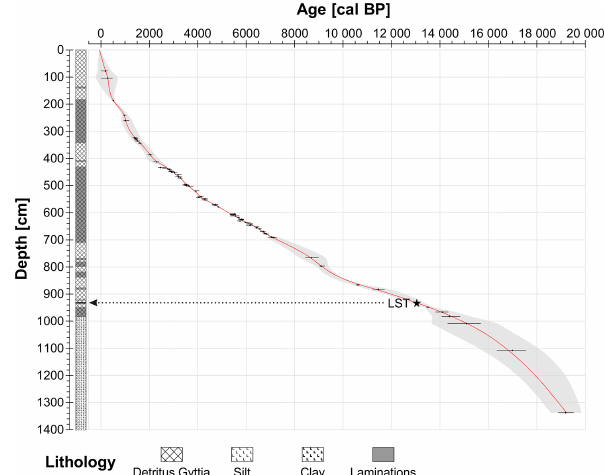
Figure 2. Age–depth model and lithology of Moossee. Black dots show the calibrated ages with 95% (2 σ ) probabilities (IntCal13; Reimer et al., 2013). The red line is the modeled chronology using OxCal 4.3 from 435 to 691cm (V-sequence; Bronk Ramsey 1994, 1995, 2001; Bronk Ramsey et al., 2001) and clam 2.2 smooth spline at smoothing level 0.3 from 0 to 435cm and from 691 to 1335cm (Blaauw, 2010). The 95% (2 σ ) probabilities of the model (grey area) were calculated again using OxCal V-sequence (435–691cm) and a generalized mixed-effect regression (GAM; 0–435cm and 691–1335cm; Heegaard et al., 2005). LST: Laacher See Tephra (black line at 932–933cm and black